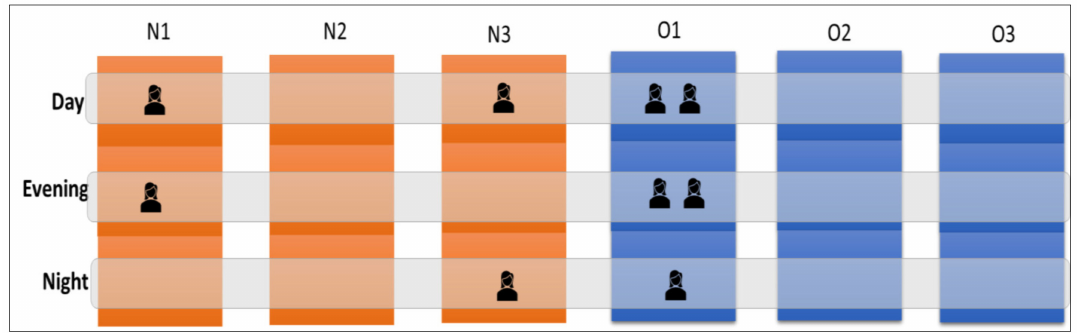
Figure 7. The configuration for flexible